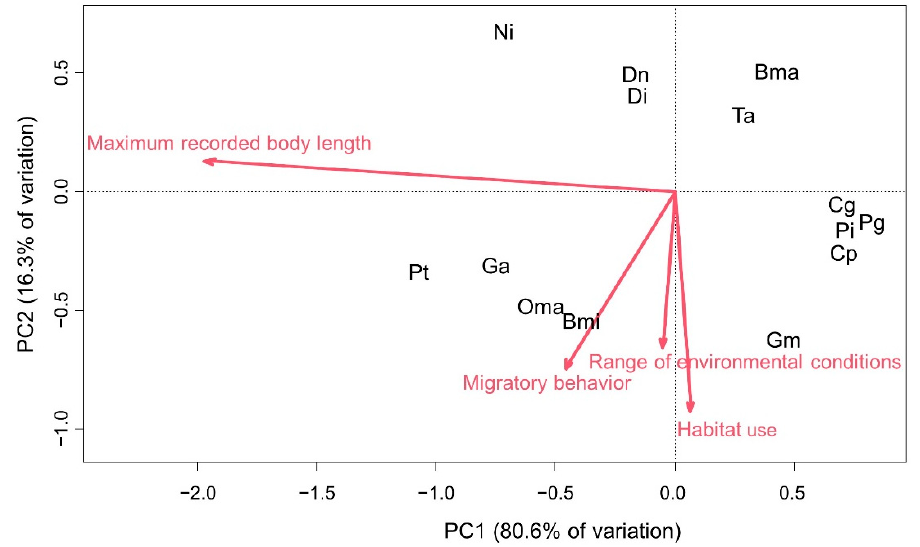
Figure 4. Principal component analysis based on biological and ecological traits that determine the dispersal capacity of the species present in the study area. Species near to the bottom on both sides of the ordination plot were considered to be characterized by high dispersal capacity, independent of the maximum recorded body length (left) or niche breadth (right). The figure shows the species (abbreviations in Table 1) and arrows that are related to each trait used in the analysis.